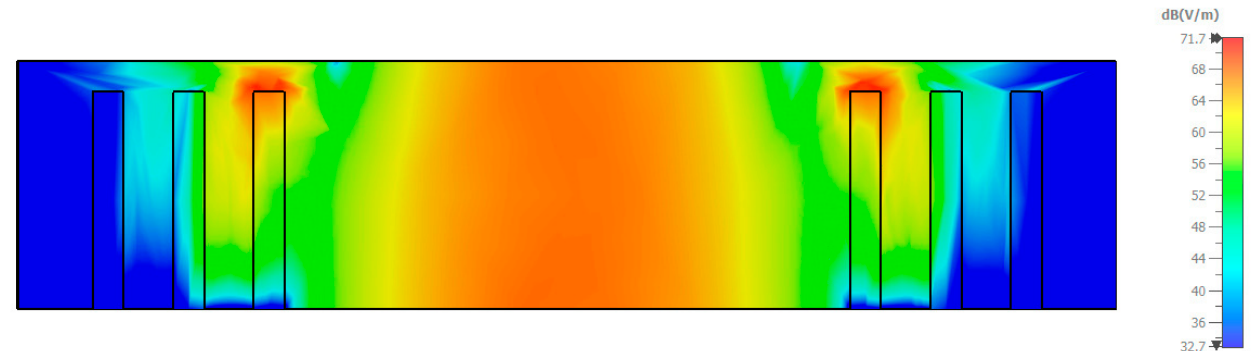
Figure 3. Groove gap waveguide scattering parameters.